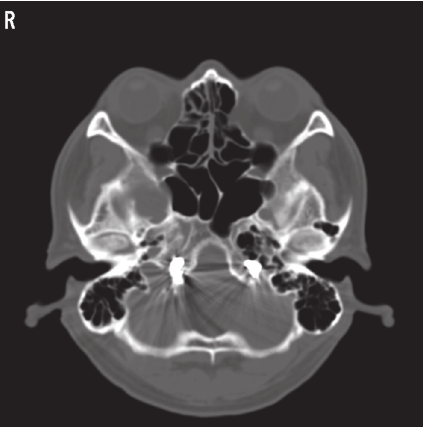
Figure 5: CT after treatment demonstrates packing coil seated in right ACC to hypoglossal canal (treated 5 years ago) and in left